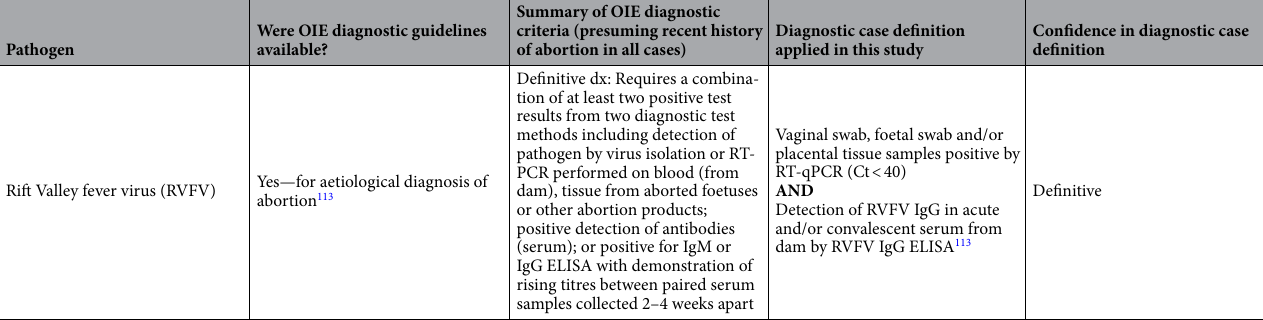
Table 5. Diagnostic criteria used by this study to attribute the aetiology of abortions in cattle, sheep, and goats reported to the abortion surveillance platform. Diagnostic case definitions apply to all three ruminant species unless otherwise specified. a See supplementary materials S1; E for further